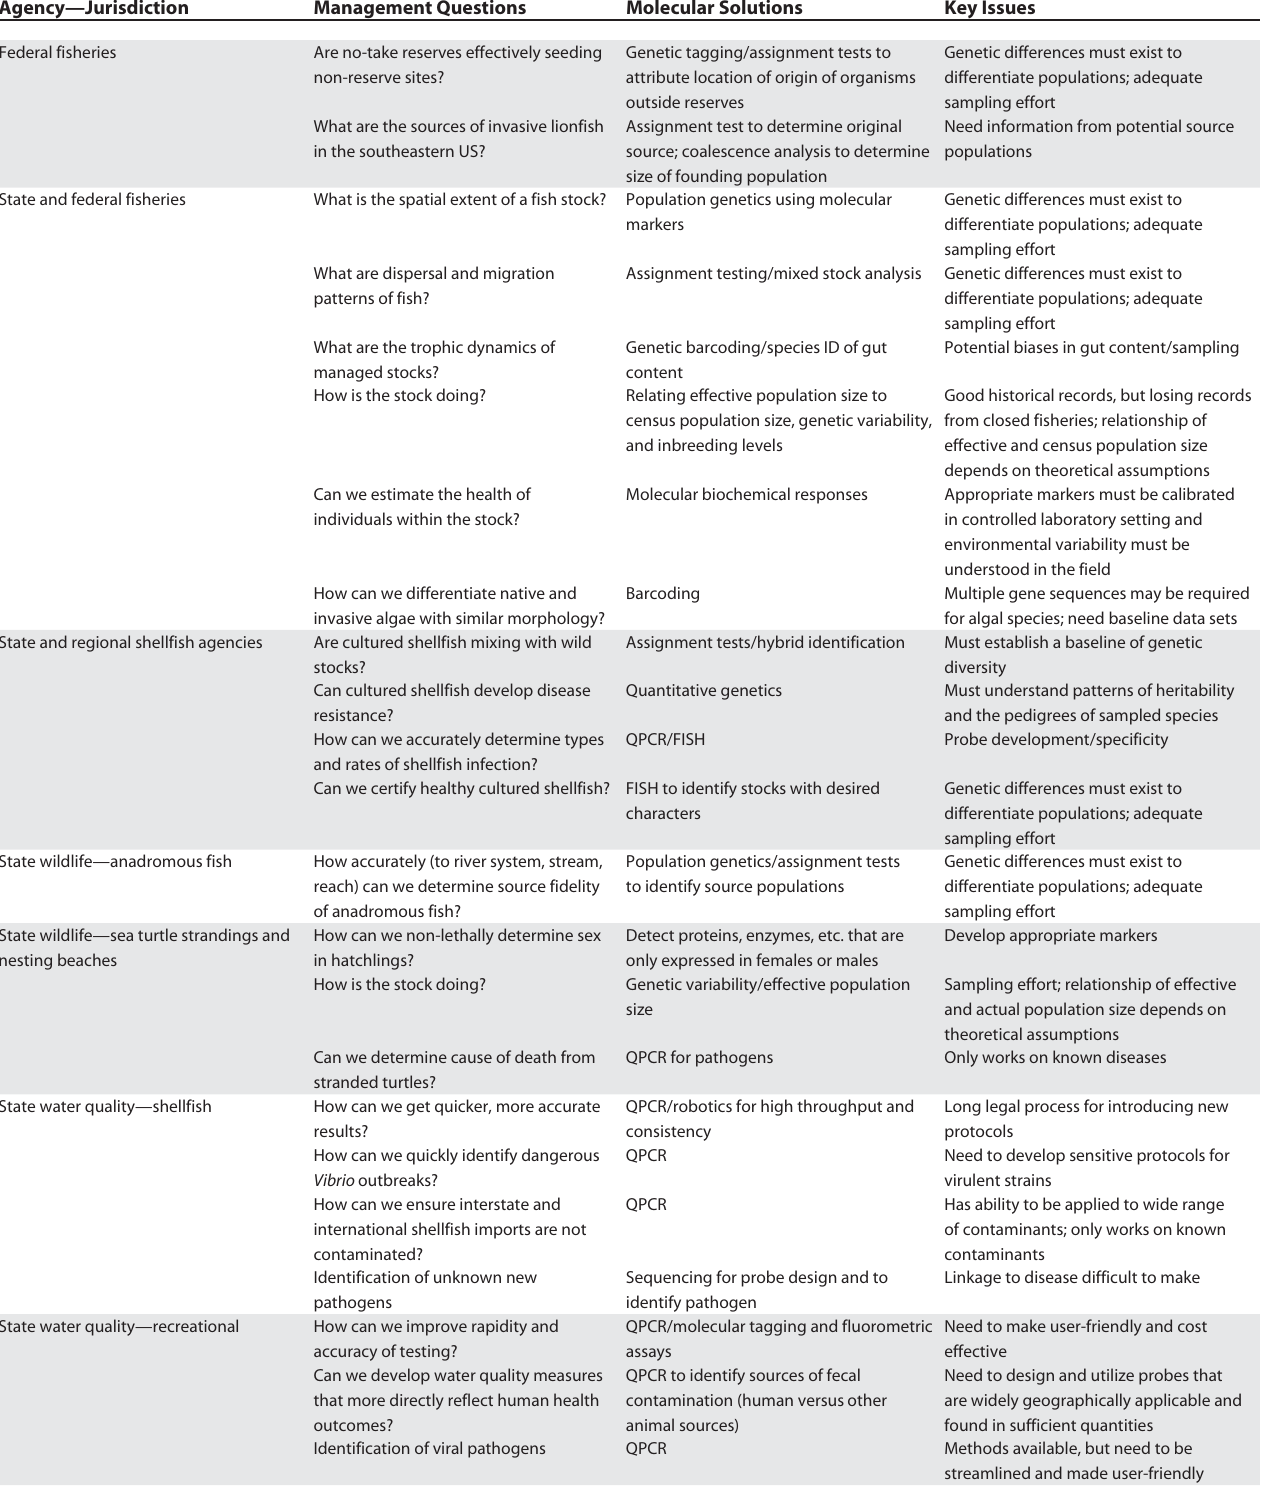
Table 1. Selected Examples of Resource Management Questions That Can Be Addressed with Molecular